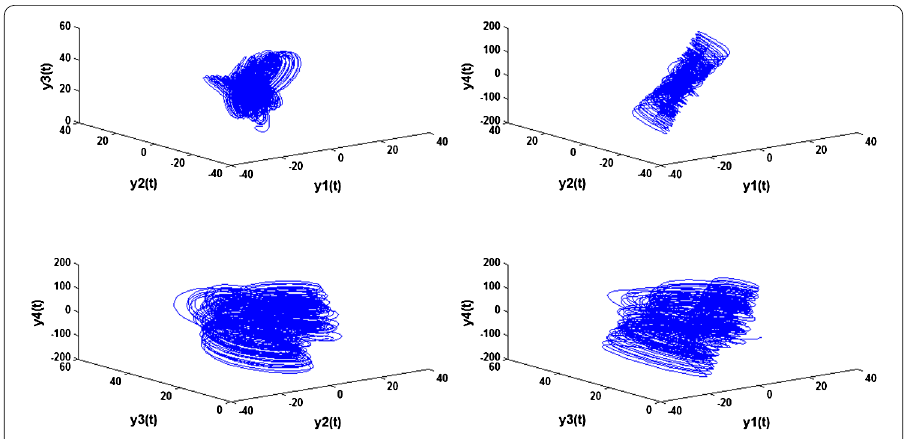
Figure 5 Different plots of the hyperchaotic attractors of the incommensurate fractional Lorenz system (37).